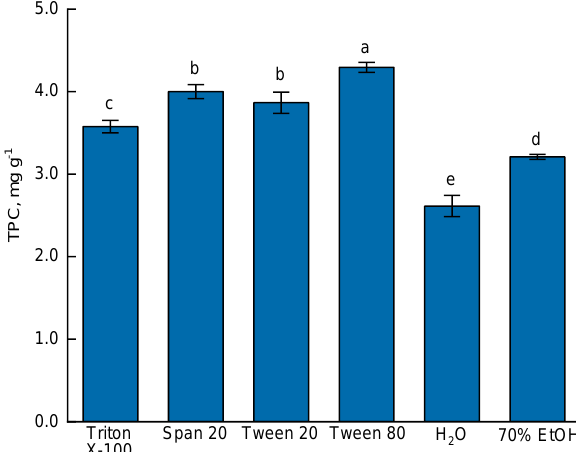
Figure 1. The impact of different types of solvents on phenolic compounds extraction from apple pomace. Extraction parameters: time—60 min, surfactant concentration—1%, solvent-to material ratio —80 mL g −1 , pH—4. Different lower case letters indicate significant differences among solvents ( p ≤ 0.05) based on post hoc Tukey’s test.